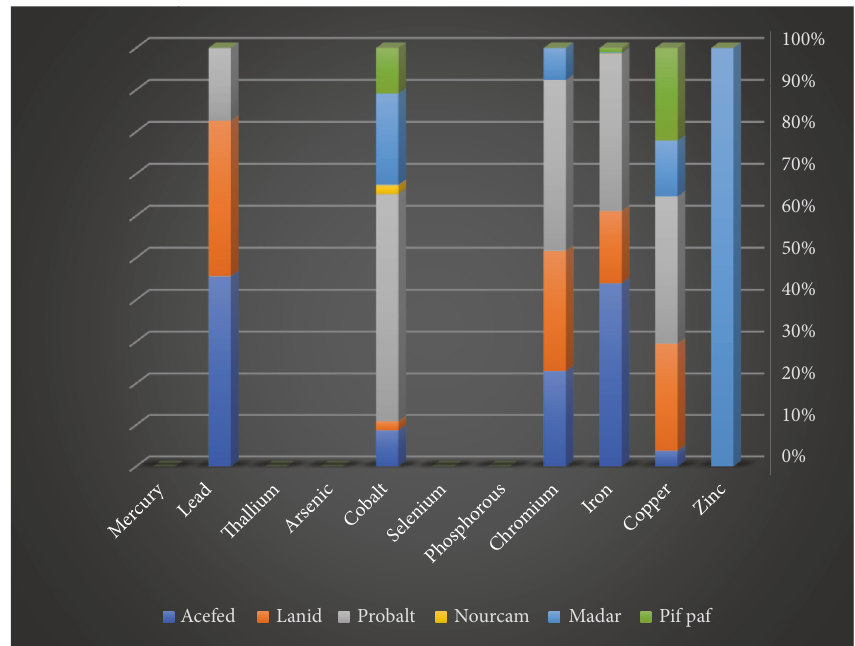
Figure 2: Proportions of the studied elements in solid insecticides samples.